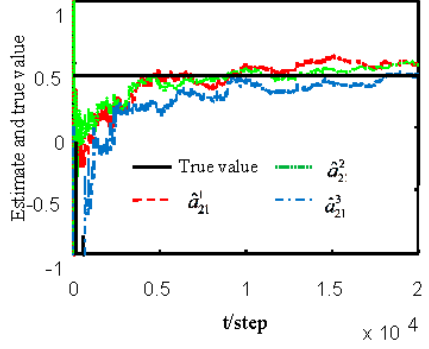
Figure 2. Local estimates of unknown parameter a 21